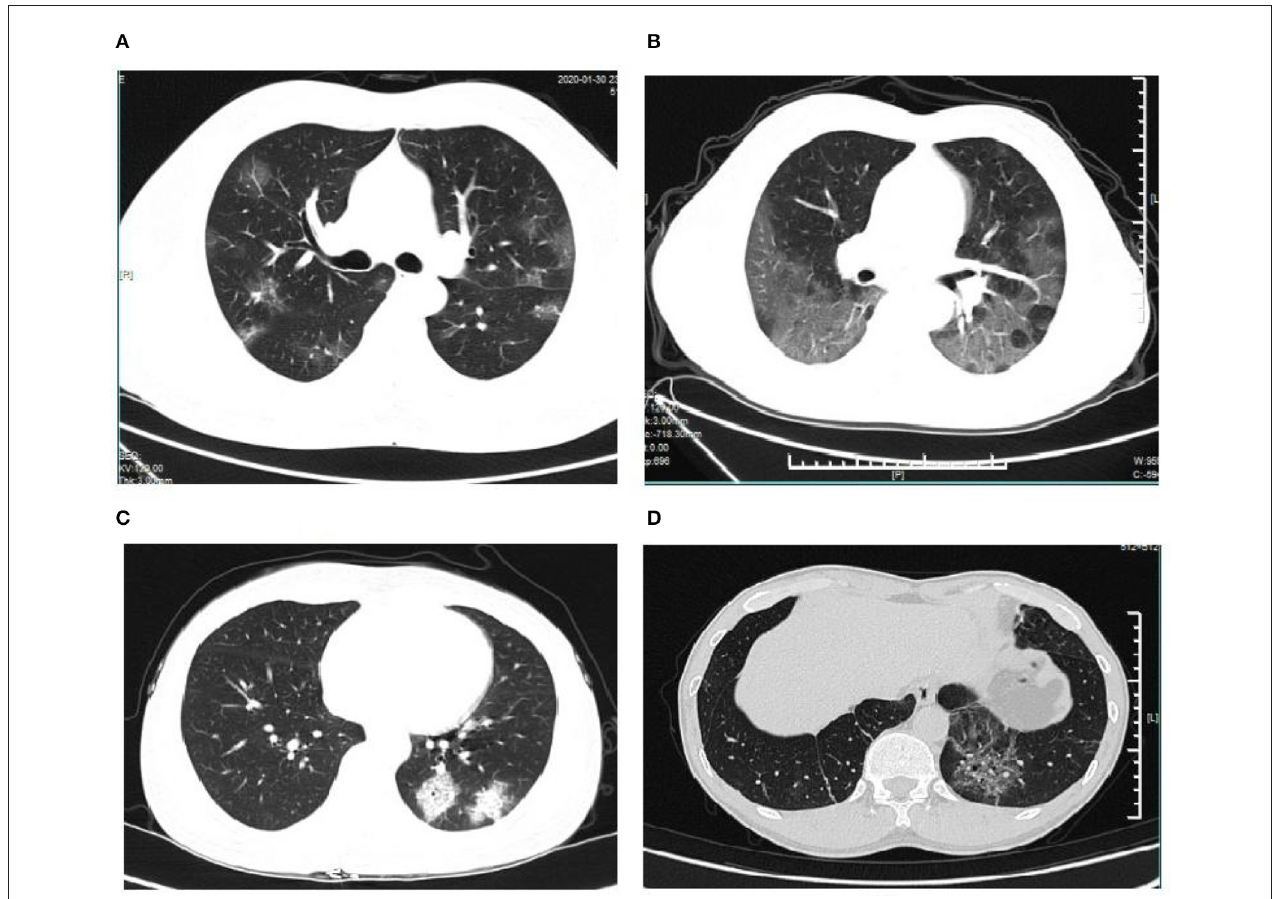
FIGURE 1 | CT-signs of pneumonia in COVID-19 patients. (A) Latticed ground glass sign; (B) white-lung sign; (C) roadstone-like sign; (D) vascular cluster